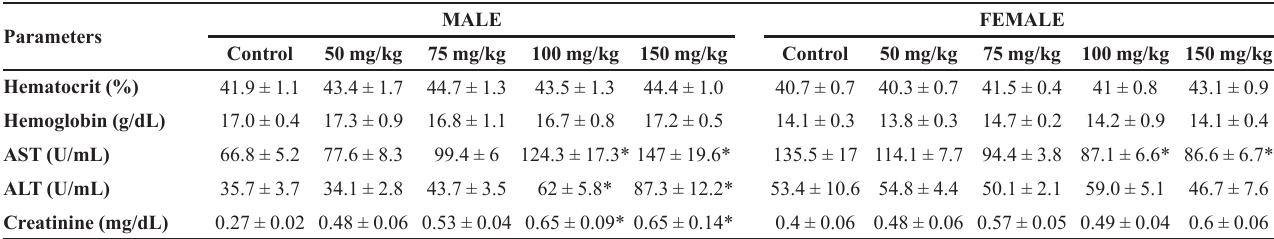
TABLE I - Hematological and plasmatic biochemical parameters evaluated in male and female Wistar rats after 28 days of treatment with a mixture of p -synephrine, ephedrine, salicin and caffeine (10:4:6:80 w/w) Parameters